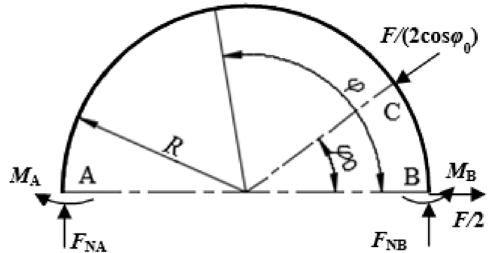
Fig. 4. Internal force of the symmetric section of the